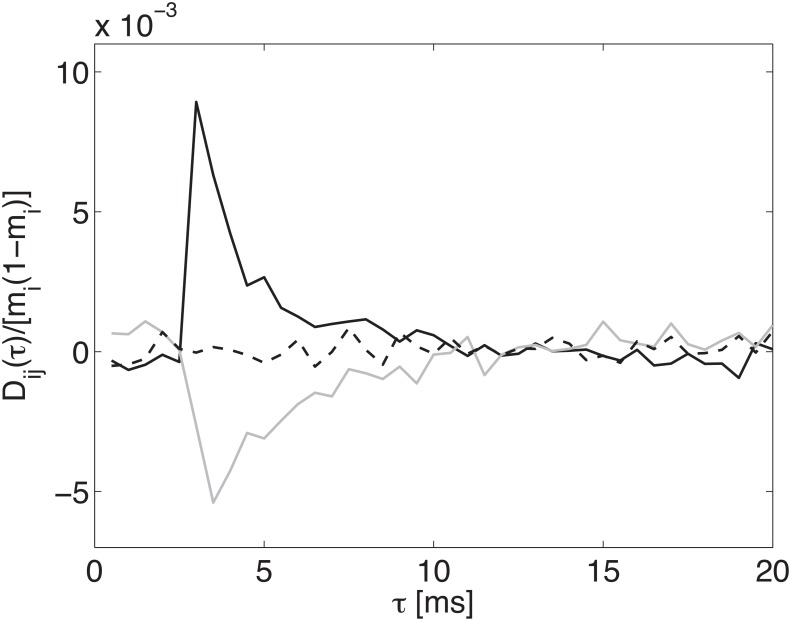
Dependence of cross-correlation D
ij on τ for a fixed pair of neurons (i, j).Excitatory synapse (thick solid line, synaptic delay δ = 3 ms), inhibitory synapse (thin solid line, synaptic delay δ = 3 ms), no synapse (dashed line), in a network with N
E = 25 excitatory neurons, N
I = 25 inhibitory neurons, connection probability c = 0.1, J
ij = ±0.54 mV, δ
ij exponentially distributed from 1 ms to 20 ms (see Methods).